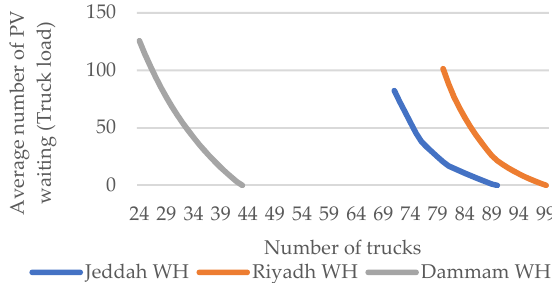
Figure 9. Average inventory of PV module in relation with the number of trucks for each warehouse.